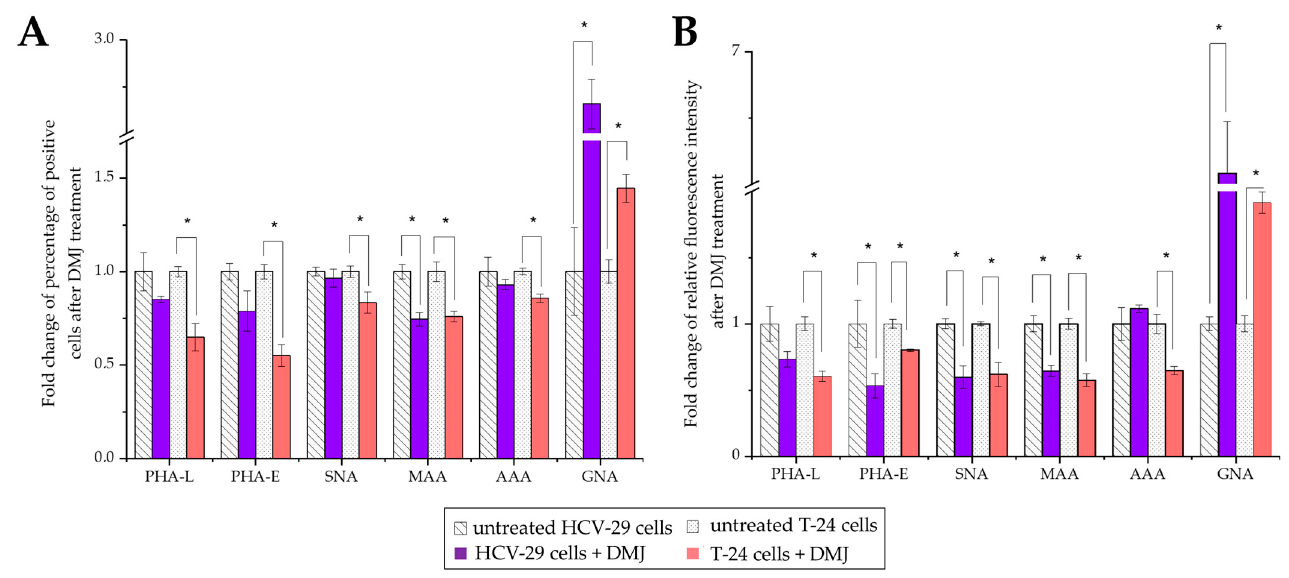
Figure 12. Flow cytometry analysis of surface glycosylation of ectosomes derived from HCV-29 and T-24 cells grown in control conditions or treated with DMJ. ( A ). Diagram showing the percentage of positive ectosomes in each staining calculated by the subtraction of the value for the unspecific binding (secondary FITC-extravidin staining) from the raw value for each lectin staining. ( B ). Diagram showing the relative fluorescence intensity (RFI) for each staining. *—denotes statistically significant differences.